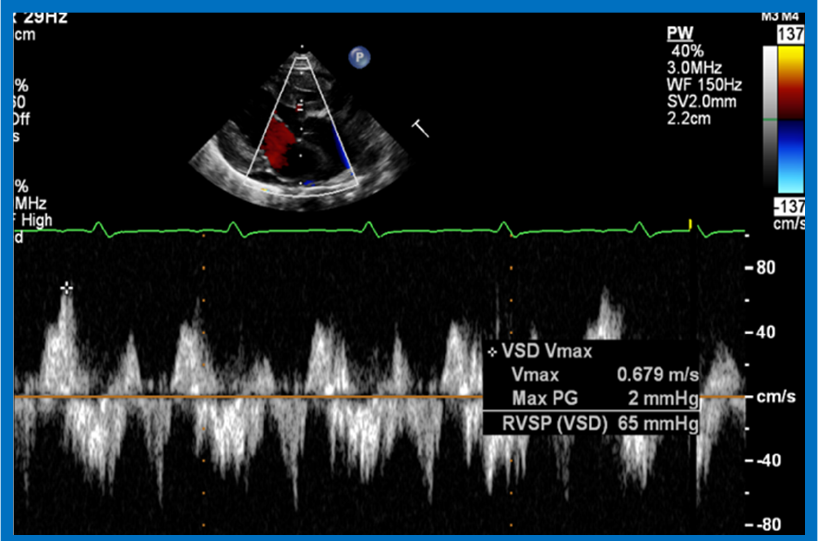
Figure 25. Selected video frame of continuous wave Doppler across the ventricular septal defect of the same baby shown in Figure 22. Low velocity flow across the ventricular septal defect suggests that the defect is nonobstructive. Reproduced from Rao P.S. [39].